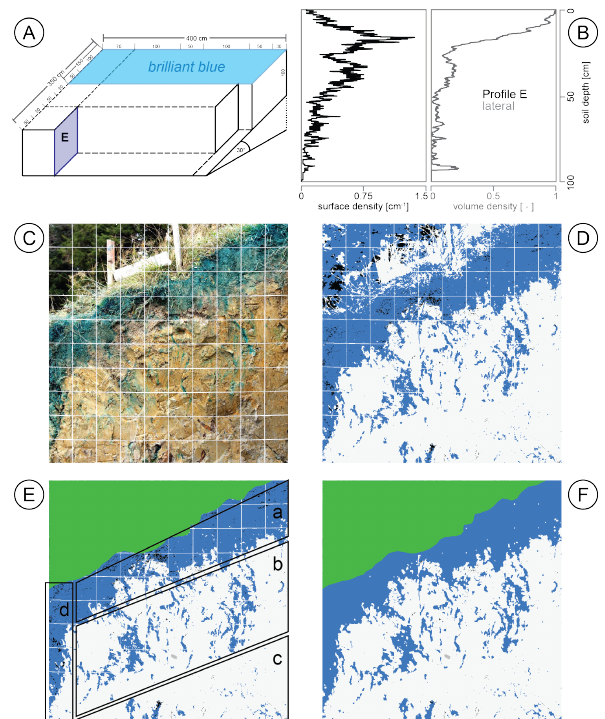
Fig. 3 Steps of the image analysis for the dye brilliant blue. (A) Location of the lateral (= parallel to the slope’s gradient) 1 m x 1 m soil profile E with dye-stained soil structures. (B) The parameters surface density and volume density are derived by the image analysis with the following steps: (C) Optical distortion and rectification correction, (D) Dye color identification based on algorithms developed by Weiler & Flühler (2004), (E) Digitalization of terrain surface (soil, vegetation, atmosphere) and large stones (gray shapes), and (F) Application of a conditional dilation algorithm to improve the dye-stained soil structures (e.g. removes the grid). Fig. 3E shows the dye staining patterns in relation to the soil horizons and structures of the gleysol: (a) organic H horizon (0 to 0.1/0.2 m) with dye-stained matrix, (b) Go horizon (0.1/0.2 to 0.5/0.6 m) with stained macropores (worm burrows), (c) Gr horizon (0.5/0.6 to 1.0 m) with few dye-stained structures, where the dye-stained area is reaching a minimum; exceptions were due to dead tree roots and (d) a stained soil fracture perpendicular to the slope’s gradient.